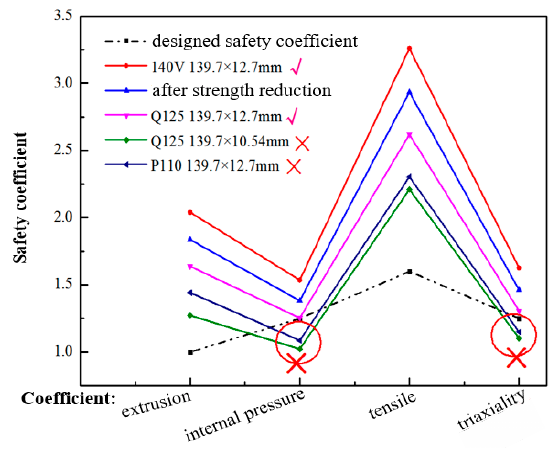
Figure 6. Verification results of production casing string.